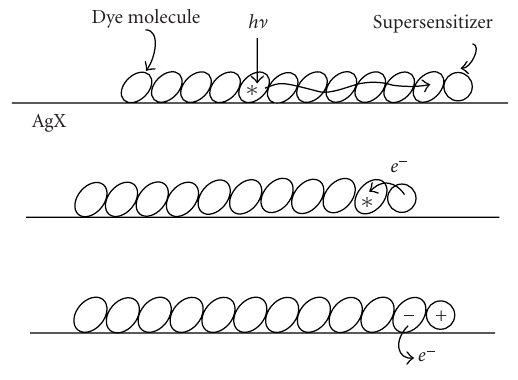
Figure 6: An illustration showing the role of an exciton in super- sensitization taking place in a J -aggregate.